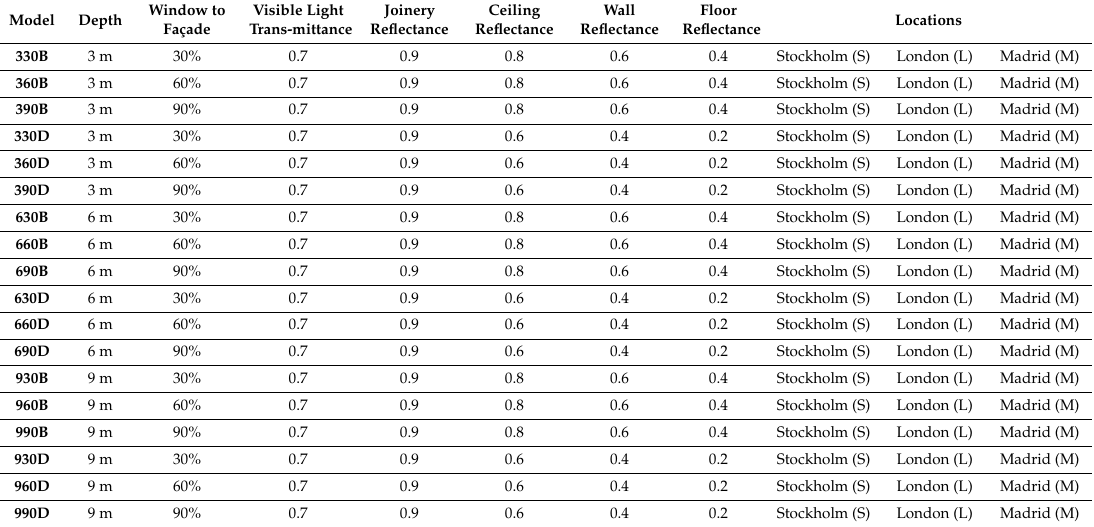
Table 1. Room models according to variables defined.